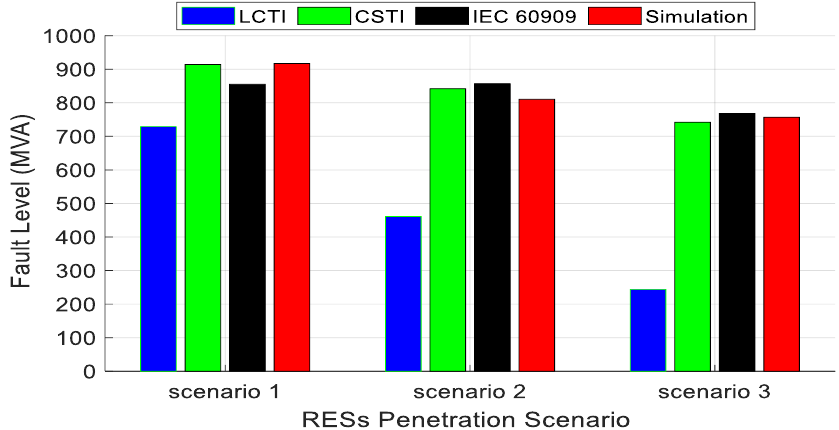
Figure 5. Bus five fault level in different penetration scenarios.